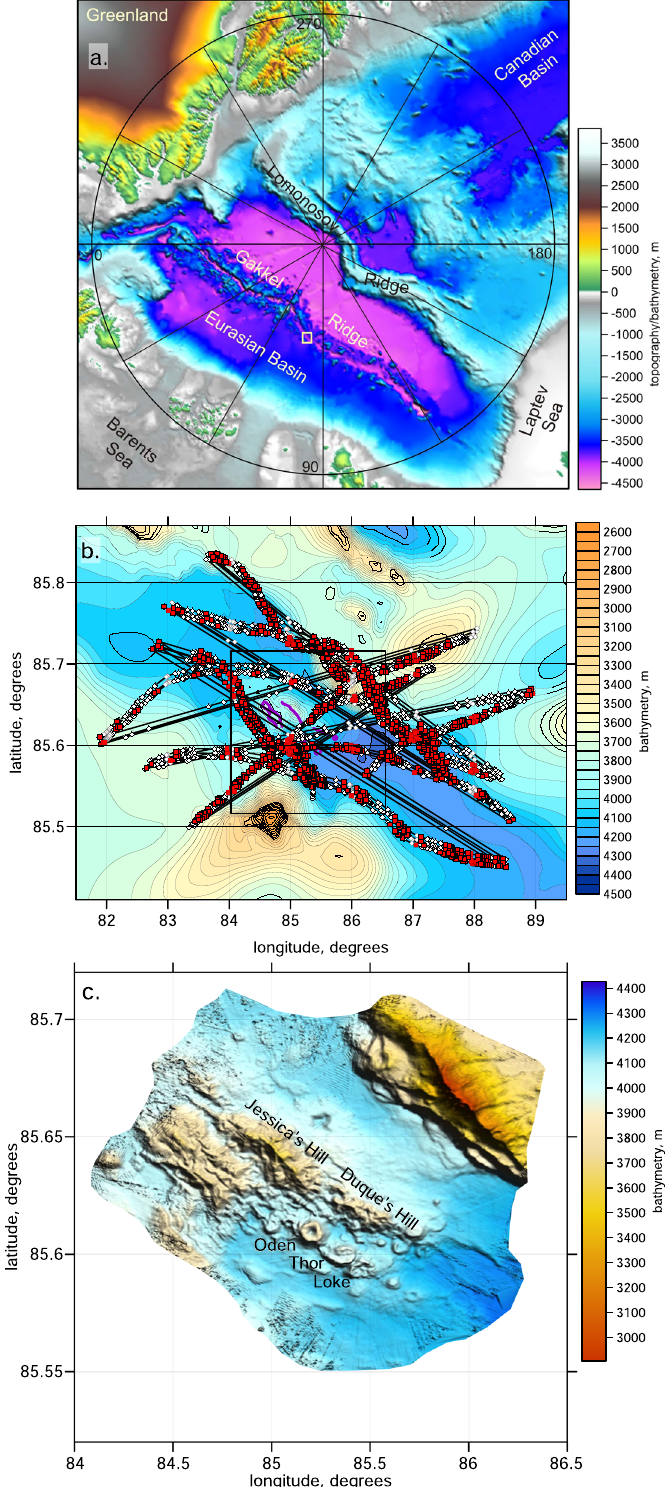
Fig. 1 Study area. a Bathymetry of the Arctic Ocean. The target area of this study is indicated by the white rectangle. b Tracks of the station migrations (thin lines). Red points indicate the station locations when they recorded local earthquakes. The background shows the bathymetry. c The detailed relief and major geological structures in the volcanic area at 85°E in the area are indicated by the rectangle in b . Bathymetry data from ref. 2